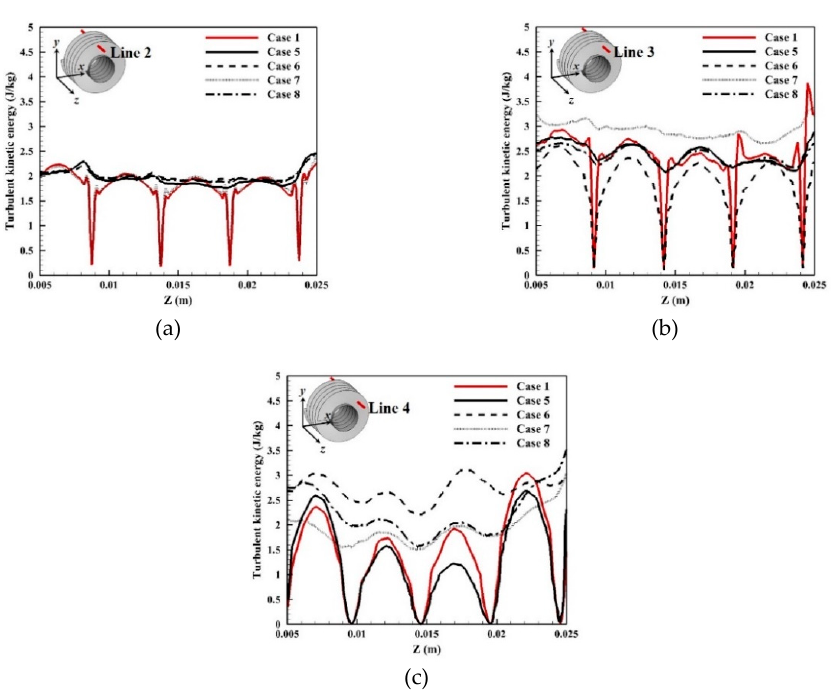
Figure 9. Comparison of turbulent kinetic energy at fixed locations along z ‐ direction at Re = 11,440. Case 1(ref.) is compared with Cases 5, 6, 7, and 8, (a) at Line 2 ( y = 0.01452 m), (b) at Line 3 ( y = 0.01258 m), and (c) at Line 4 ( y = 0.007269 m).